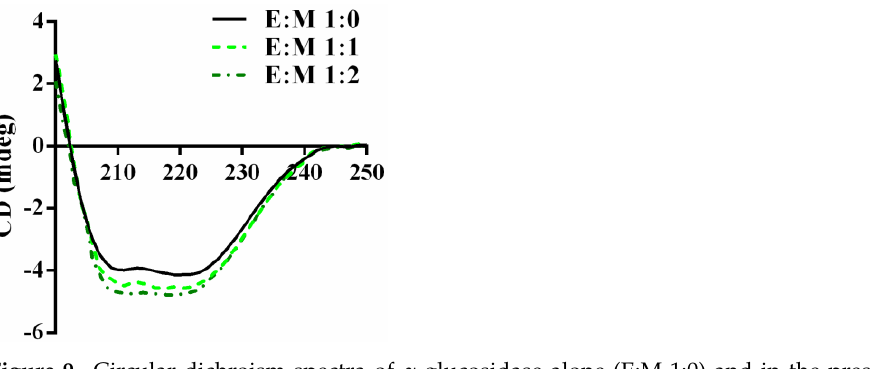
Figure 9. Circular dichroism spectra of α -glucosidase alone (E:M 1:0) and in the presence of α -mangostin (1:1 and 1:2) detected at 298 K. Table 4. The secondary structures of α -glucosidase alone and with α -mangostin detected by circular dichroism spectroscopy.